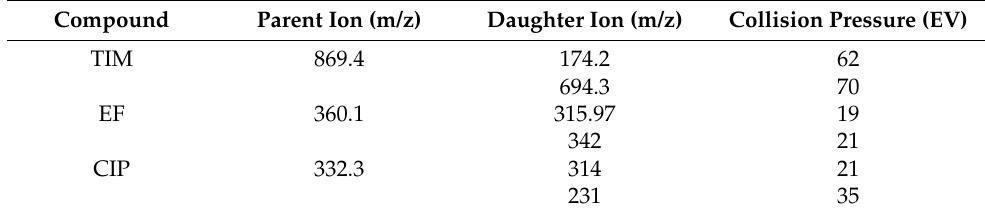
Table 1. Mass spectrometry